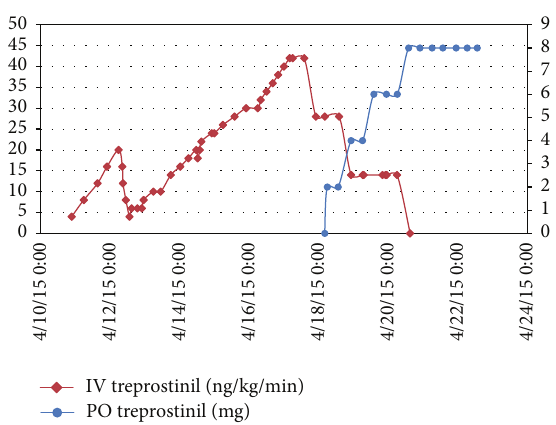
Figure 1: Graphical representation of the rapid titration of intra- venous treprostinil (red line) over seven days followed by a stepwise dose reduction while transitioning to oral treprostinil (blue